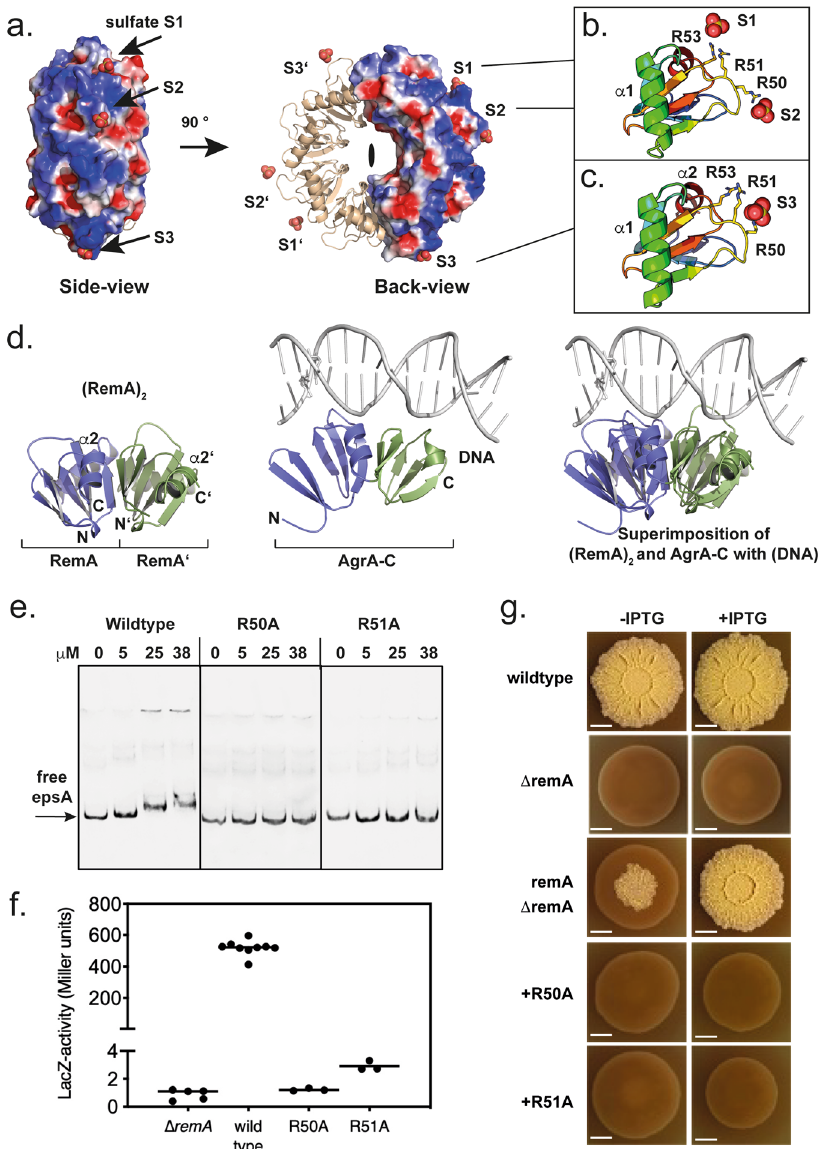
Fig. 2 DNA-binding by RemA. a Electrostatic surface of the RemA 8-mer (side and back view, PDB-ID: “ 7BM2 ” ). ‘ S ’ indicates sulfates found at the surface of the crystal structure. A detailed view on the coordination of the sulfates S1, S2, and S3 is given in fi gure panels ( b ) and ( c ), respectively. d Structure of a RemA dimer of (RemA) 8 (left side; PDB-ID: “ 7BM2 ” ), AgrA-C bound to DNA (middle; PDB-ID: “ 3BS1 ” ), and the superimposition of both (right side). e EMSAs of wild type RemA, RemA-R50A, and RemA-R51A with a DNA fragment containing the regulatory epsA region. Results were con fi rmed with